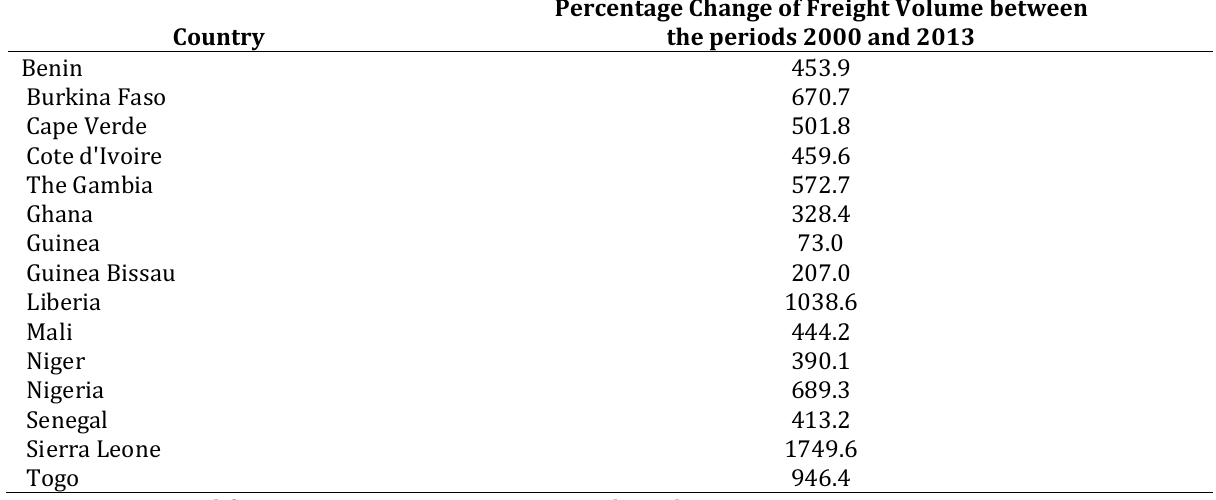
Table 3: Change in freight volume in ECOWAS states Country